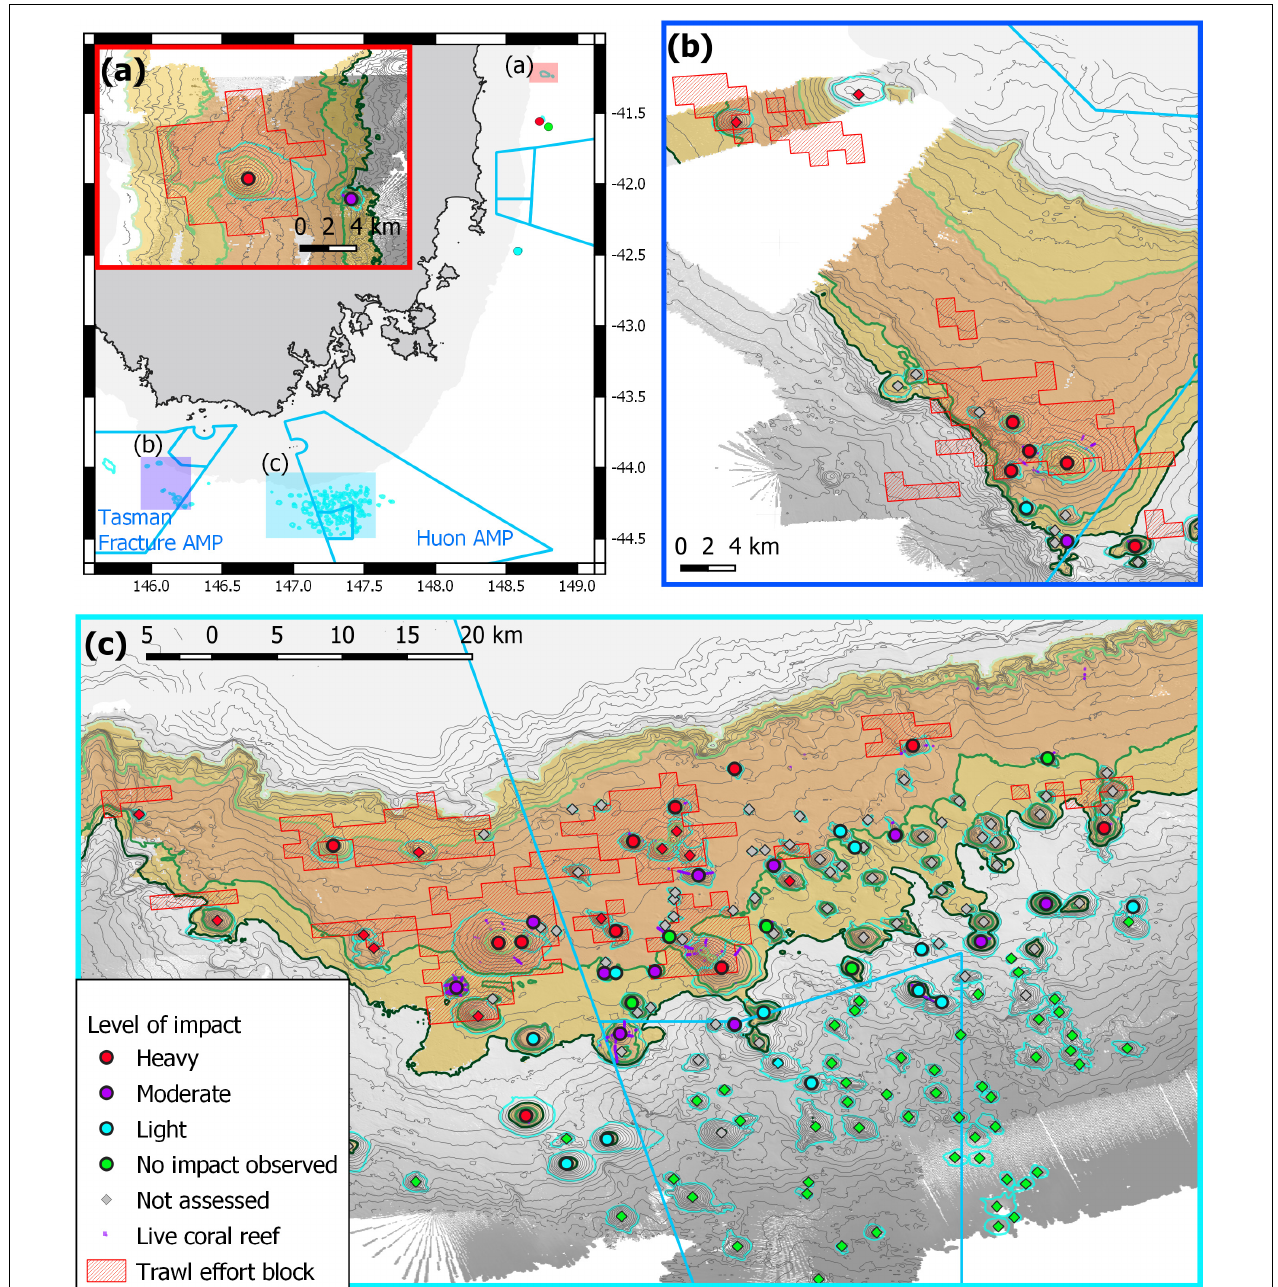
FIGURE 10 | Map of region showing the relative level of impact for surveyed seamounts (circles) and unsurveyed seamounts (diamonds), and areas of live deep-sea coral reef formed by Solenosmilia variabilis . Background shading shows primary depth ranges relevant to scleractinian coral reefs and trawling effort: pale orange – inshore of seamount fishery (500–650 m); brown – shallow (650–950 m) range of coral reef and blocks of concentrated trawling effort; orange – intermediate (950–1,500 m) depth range of scleractinian coral reef and some trawling effort; and grey – deep ( > 1,500 m) range beyond the depths of living scleractinian coral reef and operational depth of trawl fishery. Australian Marine Park (AMP) boundaries in light blue: (a) overview map showing the relative locations of the three study areas, with inset showing sites at the St Helens Seamount and one adjacent seamount; (b) sites in and adjacent to the Tasman Fracture AMP; (c) sites in and adjacent to the Huon